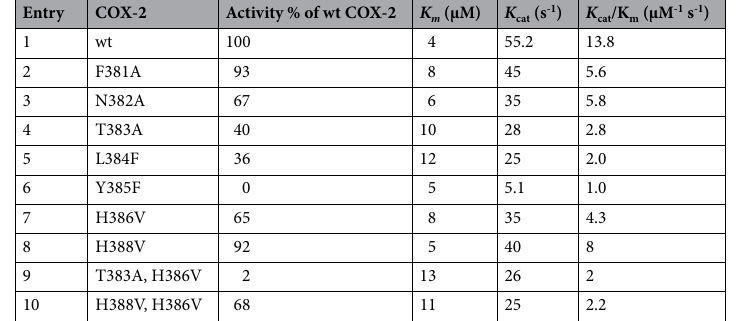
Table 1. Catalytic activity of COX-2 for AA metabolism in terms of PGE 2 formation (ng/mL) and kinetic constants. Average of 3 expts, SD ± 0.5–2.0.